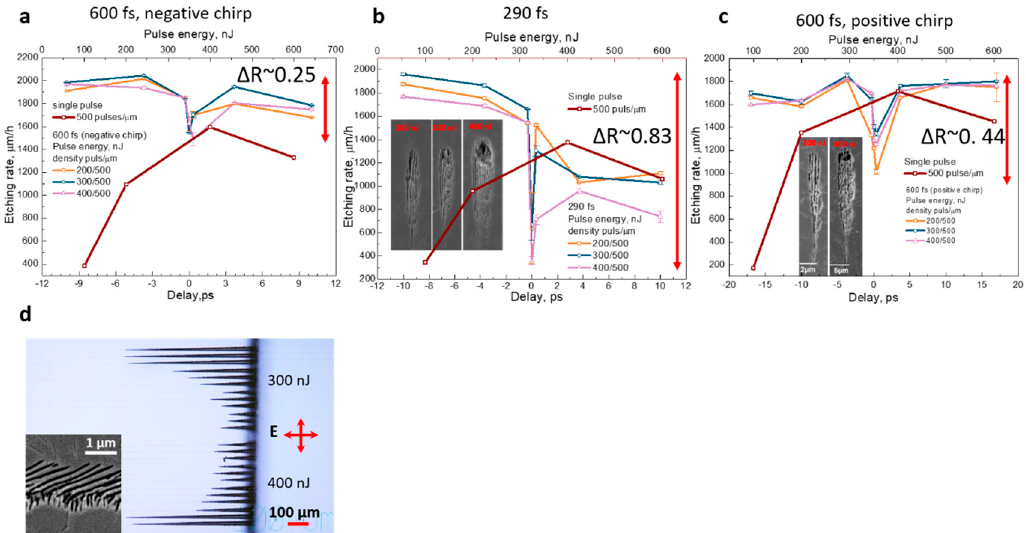
Figure 4. The etching rate dependence on the delay between two pulses for modifications recorded in fused silica with the 200–400 nJ pulse energy and orthogonal polarisations: ( a ) 600 fs pulse duration with a negative chirp; ( b ) 290 fs pulse duration; ( c ) 600 fs pulse duration with a positive chirp; ( d ) The microscope picture of etched channels for the 0 fs pulse delay at 290 fs pulse duration. Red curve: the etching rate dependence on the pulse energy for a single pulse. Samples were etched 30 min in 10% diluted hydrofluoric acid (HF) acid. The inset shows the SEM pictures from the side (b and c) and top (d).